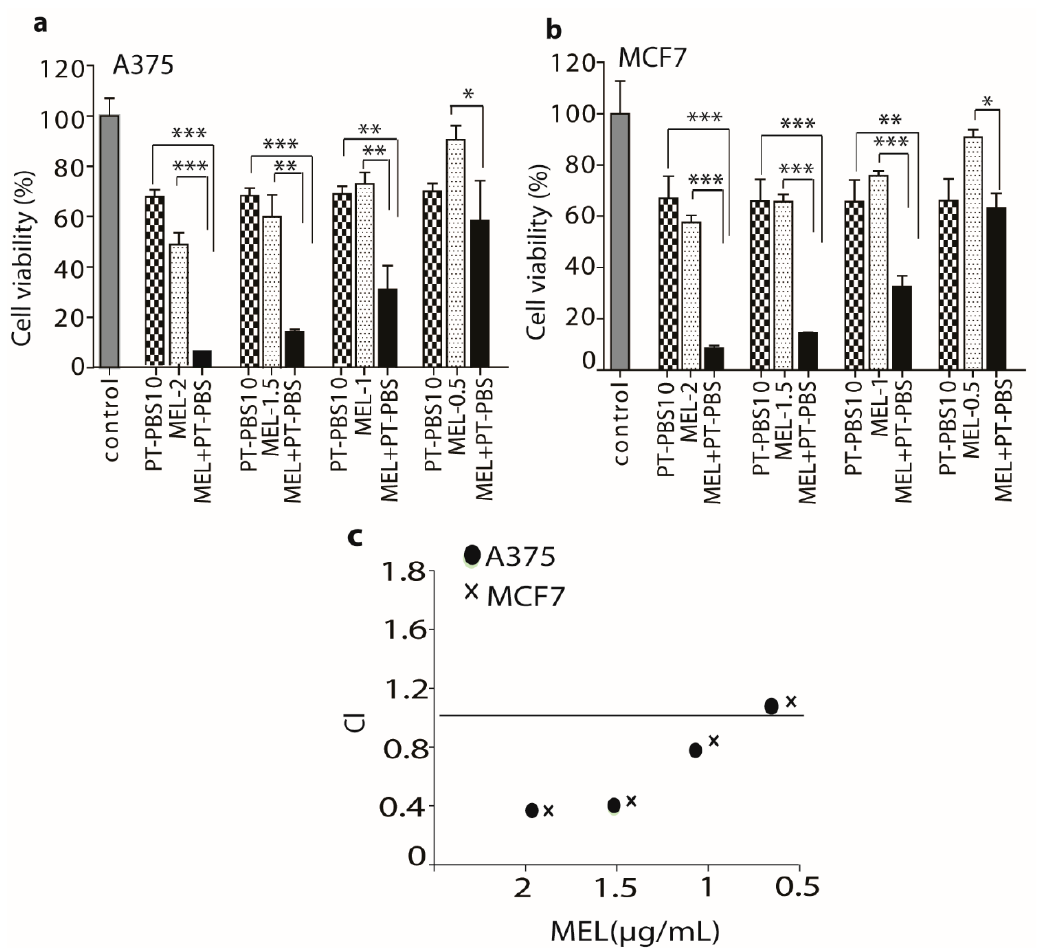
Figure 4. Analysis of cell viability of ( a ) A375 and ( b ) MCF7 cells treated with a fixed dose of PT-PBS (10%), and varying doses of MEL (i.e., 2, 1.5, 1 and 0.5 µg/mL) alone and in combination, 24 h after treatment. ( c ) Combination index (CI) of PT-PBS (10%) with MEL (at 2, 1.5, 1 and 0.5 µg/mL), in A375 and MCF7 cells (see text). All values are expressed as mean ± SD; * = p ≤ 0.05; ** = p ≤ 0.01; *** = p ≤ 0.001.